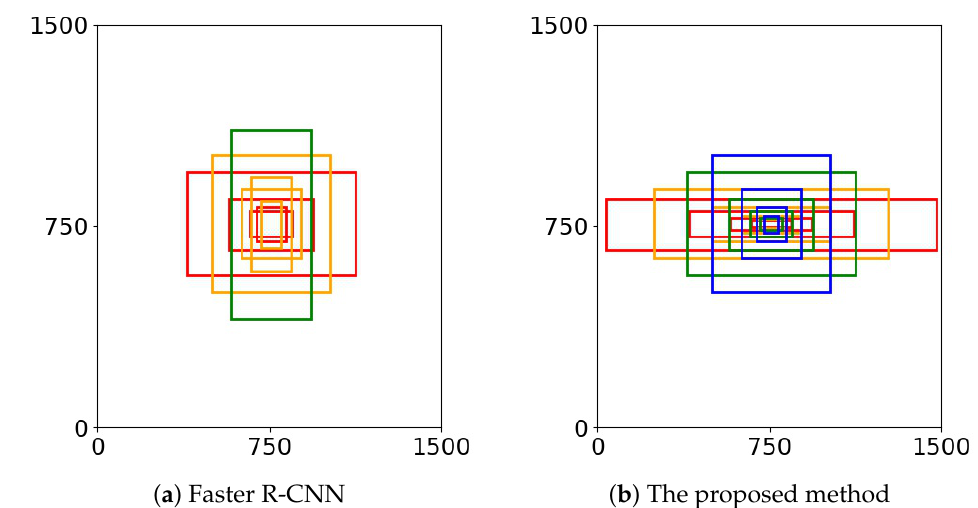
Figure 4. Comparison on